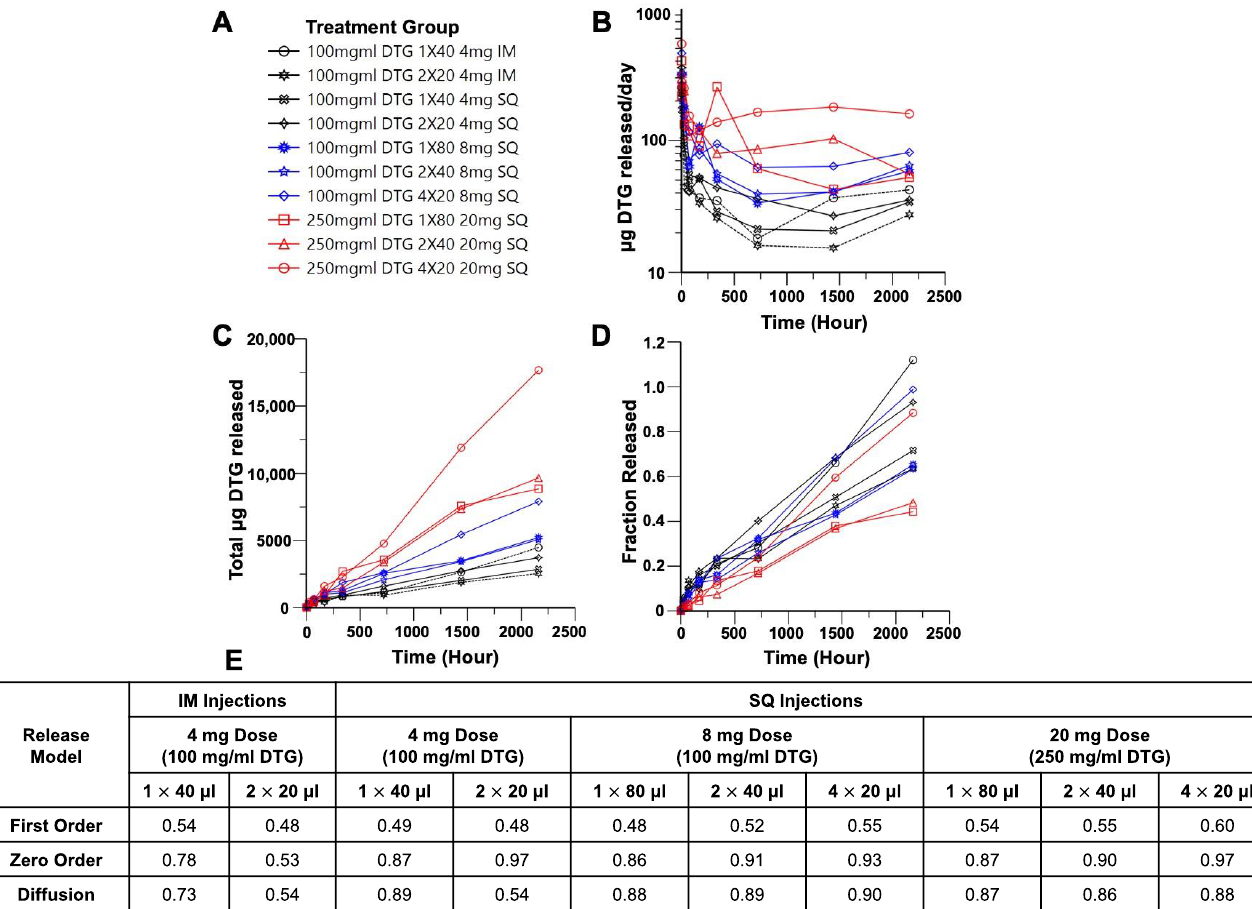
Figure 7. Median estimated deconvolution parameters of 4 × 20, 2 × 40, and 1 × 80 μ L DTG-loaded ISFIs (1:2 w / w PLGA/NMP): ( A ) Legend for panels B-D. ( B ) Median estimated DTG release rate over 90 days. ( C ) Median estimated cumulative DTG mass over 90 days. ( D ) Median estimated fraction of loaded DTG dose over 90 days. ( E ) r 2 values for mathematical models of first order, zero order, and diffusion-controlled (Higuchi model) release.